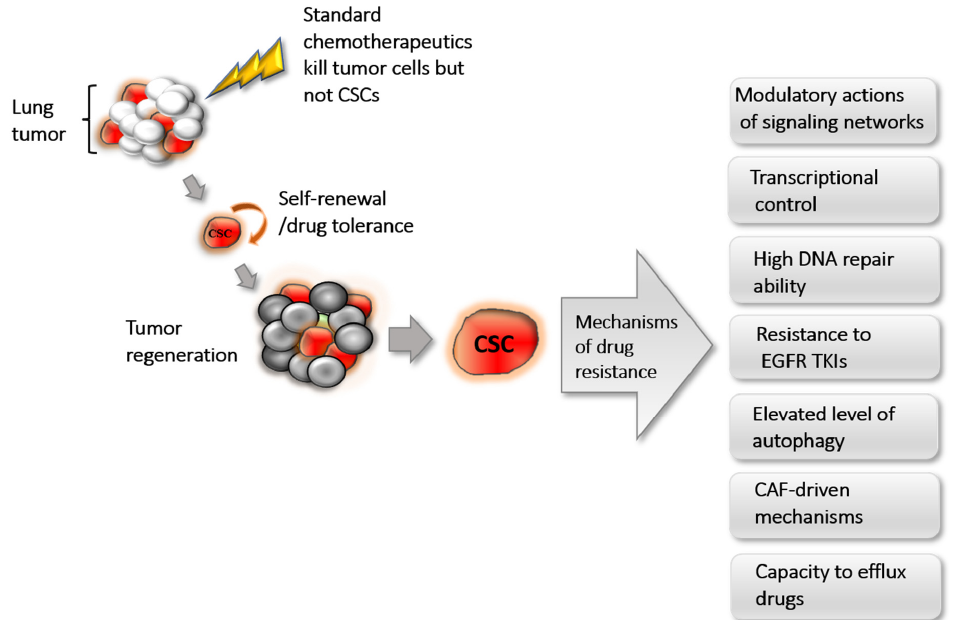
Figure 1. The CSC-mediated mechanisms of drug resistance in lung cancer are multifactorial. CSCs are known to escape conventional therapy and are able to regenerate the bulk of the tumor, causing disease recurrence. The literature reviewed herein asserts that CSCs are recalcitrant to effective treatment because of the modulatory actions of diverse signaling networks, aberrant transcriptional control, high DNA repair ability, resistance to EGFR TKIs, elevated autophagy, presence of cancer- associated fibroblast (CAF)-driven mechanisms, and ability to efflux drugs through ABC transporters in SP cells. CSC, cancer stem cells; EGFR, epidermal growth factor receptor; TKIs, tyrosine kinase inhibitors; SP, side population; ABC, ATP-binding cassette.